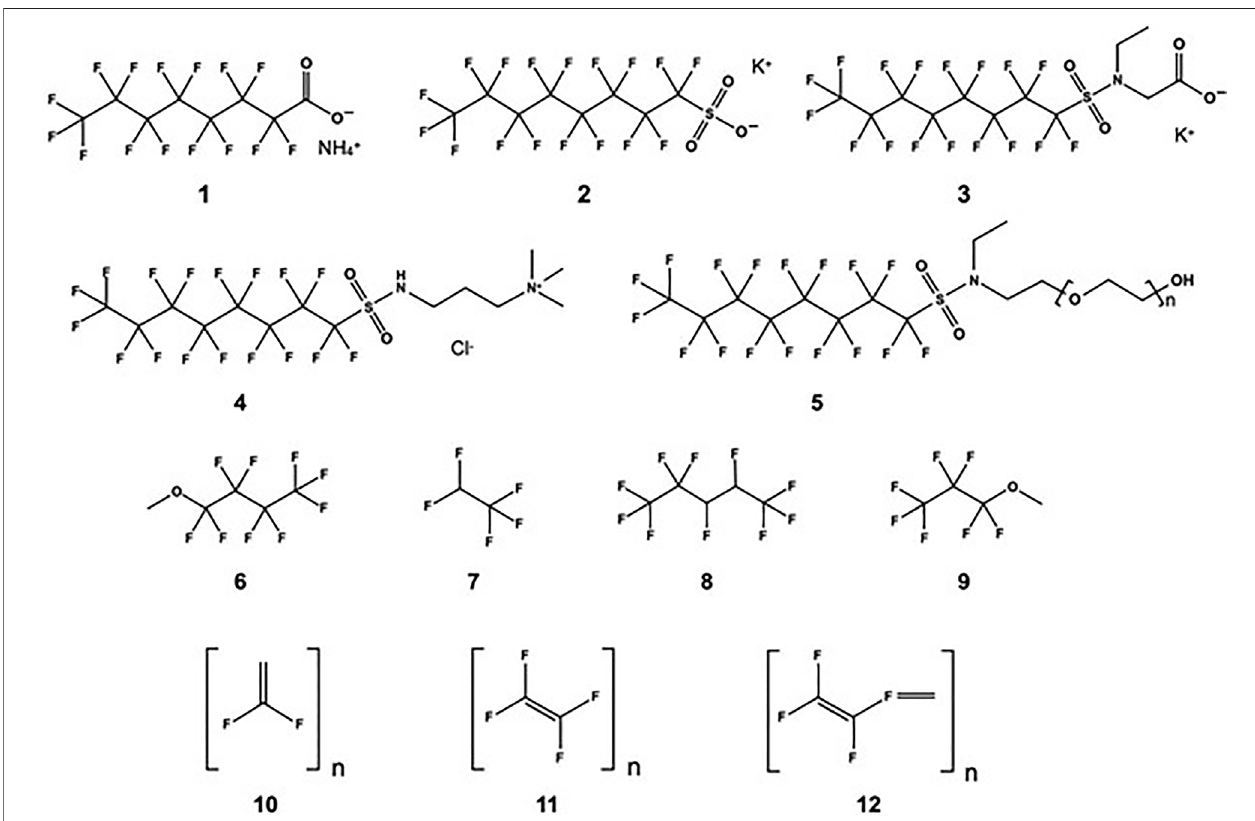
FIGURE 2 | Structures of the PFAS with more than 10 assigned uses: 1 CAS No. 3825 – 26 – 1, 2 CAS No. 2795 – 39 – 3, 3 CAS No. 2991 – 51 – 7, 4 CAS No. 38006 – 74 – 5, 5 CAS No.29117 – 08 – 6, 6 CAS No.163702 – 07 – 6, 7 CASNo.364 – 33 – 6, 8 CAS No.138495 – 42 – 8, 9 CAS No.375 – 03 – 1, 10 CAS No.24937 – 79 – 9, 11 CAS No. 9002 – 84 – 0 and 12 CAS No. 25 – 038 – 71 – 5. Adapted from (Glüge et al., 2020).